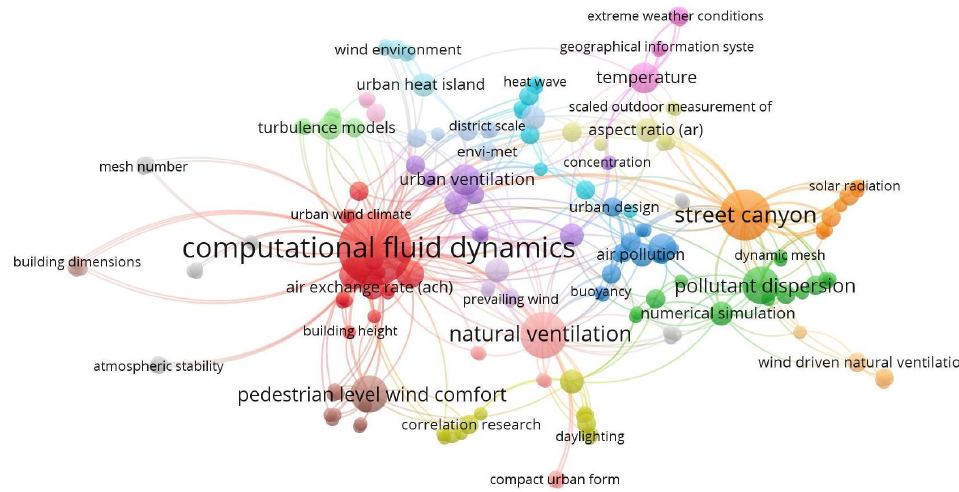
Figure 5. VOSviewer keywords